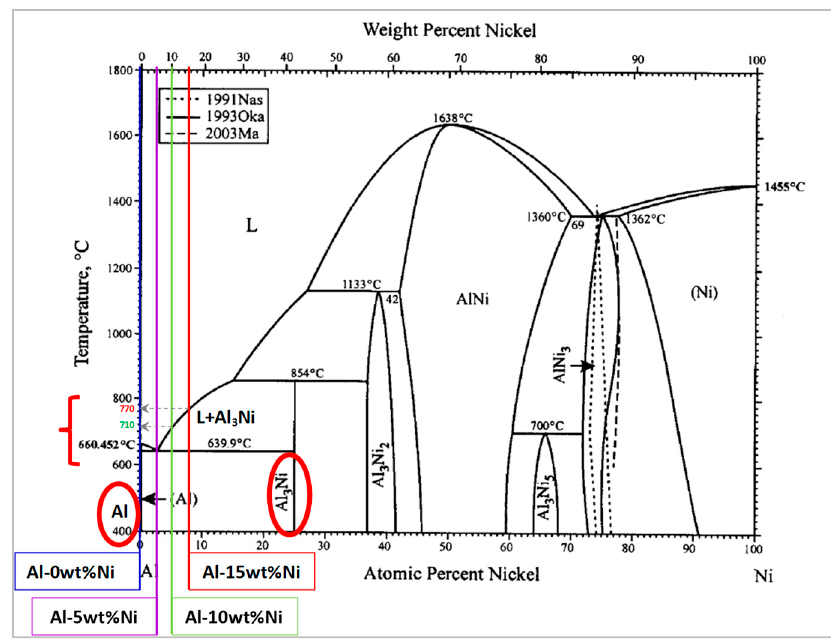
Figure 5. Al–Ni phase diagram showing the Ni additions—adapted from Reference [40].